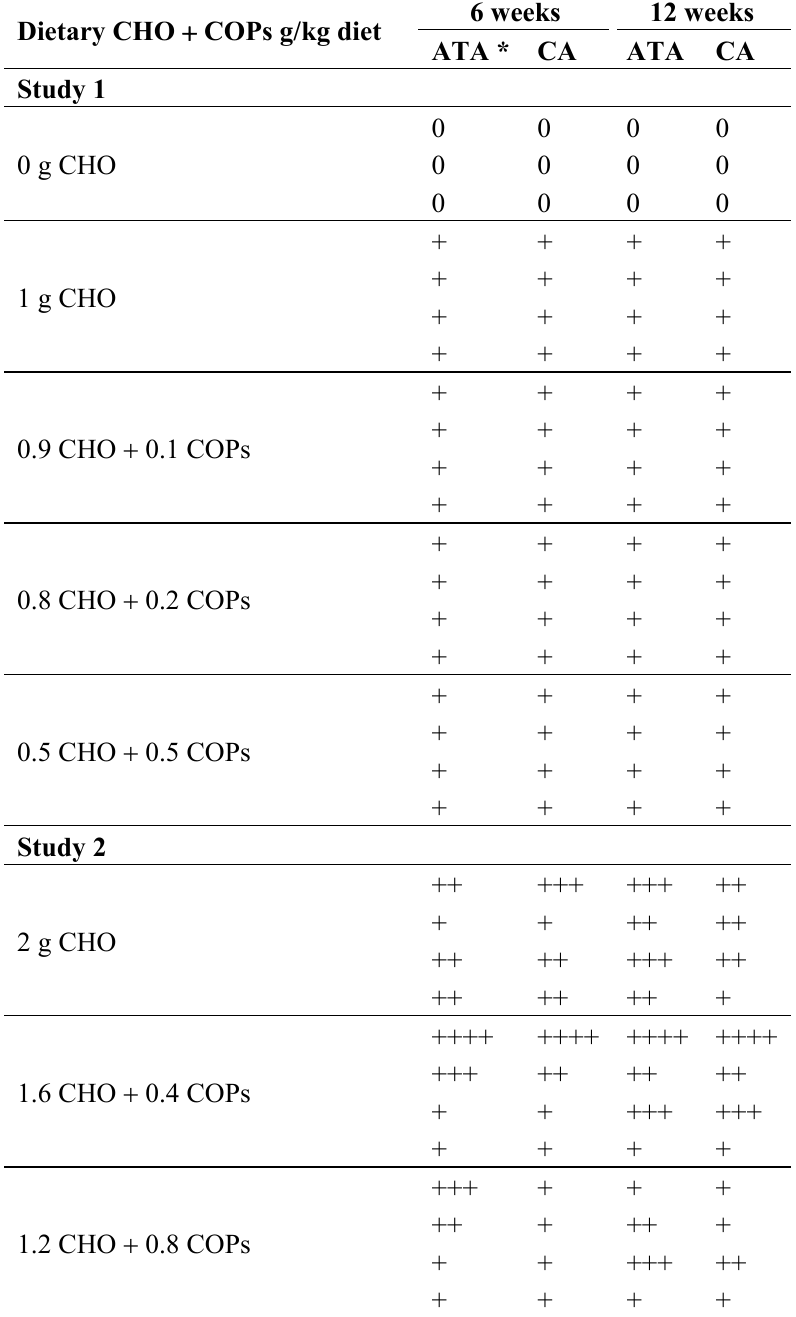
Table 1. Atherosclerotic lesions in ascending thoracic aorta and coronary artery of individual rabbits after feeding diets containing different amounts of cholesterol (CHO) and cholesterol oxides (COPs) for 6 or 12